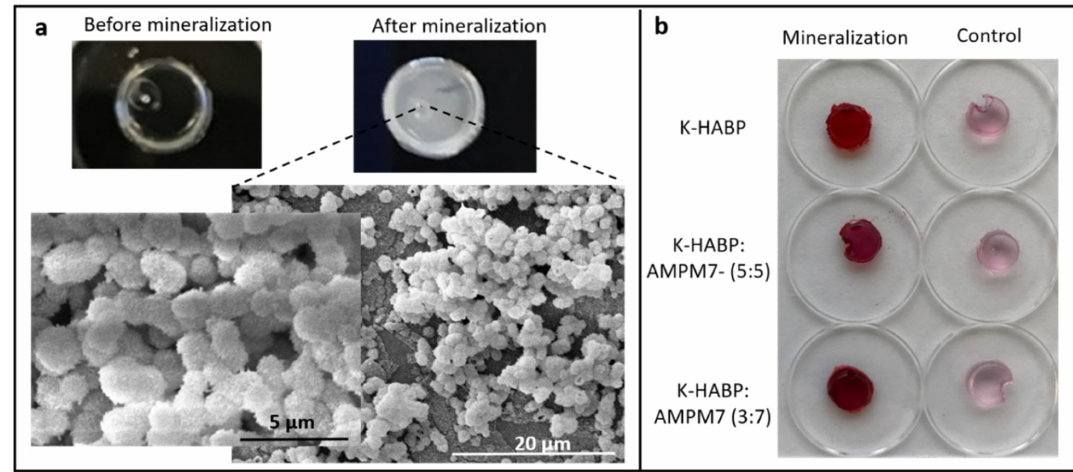
Figure 8. ( a ) K-GSGGG-HABP:AMPM7 integrated polymer disc samples were monitored under SEM after overnight mineralization reaction. ( b ) Peptide integrated polymer discs after mineralization were stained with Alizarin Red. The same type of discs without mineralization were used as